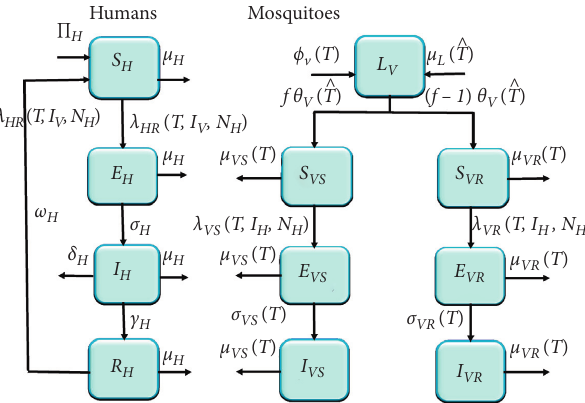
Figure 13: Flow diagram of the malaria-resistant model (21).